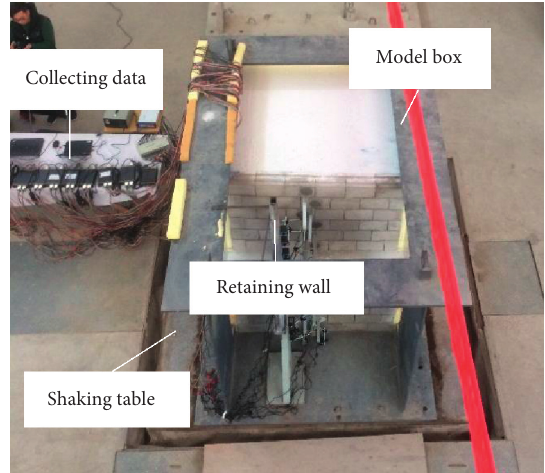
Figure 2: Model test